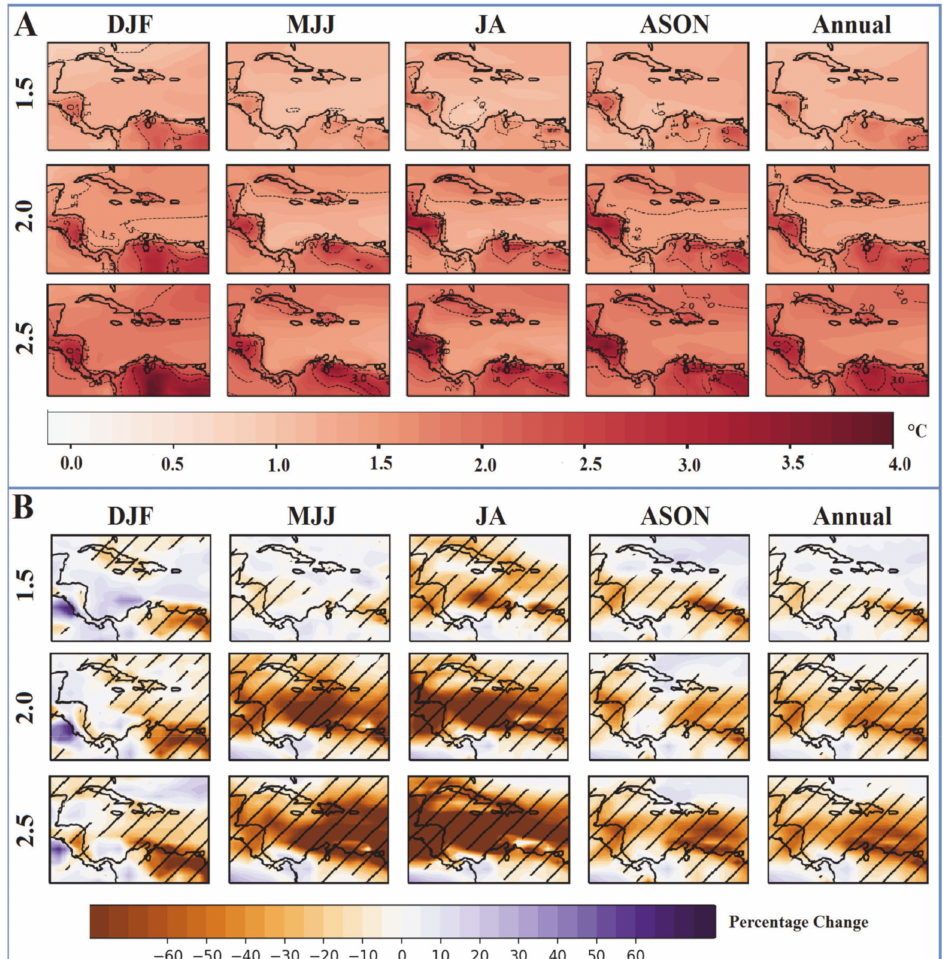
Figure 6. Difference maps of air temperature (panel ( A )) and precipitation (panel ( B )) from HadGEM_unaltered. Differences are between the 11-year composites centered on when global average temperature attains the 1.5, 2.0 and 2.5 ◦ C targets (row 1, columns 4–6 of Table 1) and composites of the pre-industrial period (1860 to 1900). For precipitation, differences are expressed as percentage changes with respect to the pre-industrial period. Statistically significant differences are hatched for